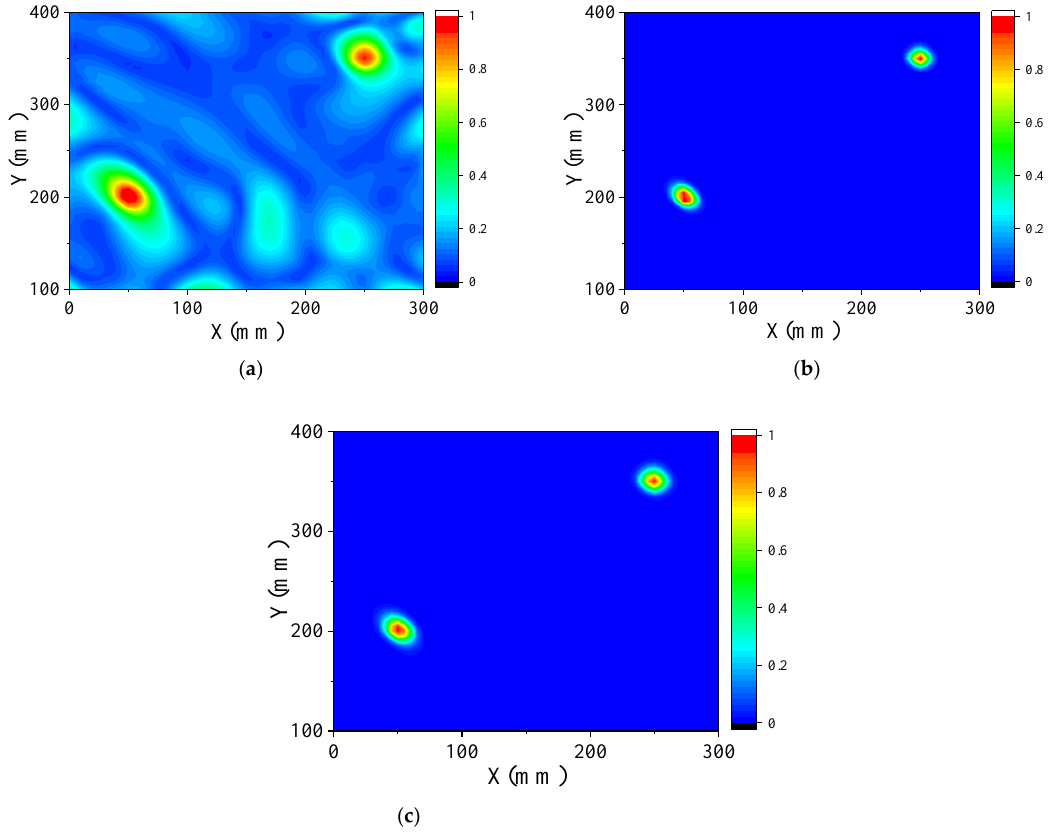
Figure 10. The imaging results of UWB-CS and SI-CS for double PIM sources: ( a ) UWB-CS and ( b ) SI-CS with δ = 0.6 and µ = 0.5 and ( c ) SI-CS with δ = 0.6 and µ = 0.8.